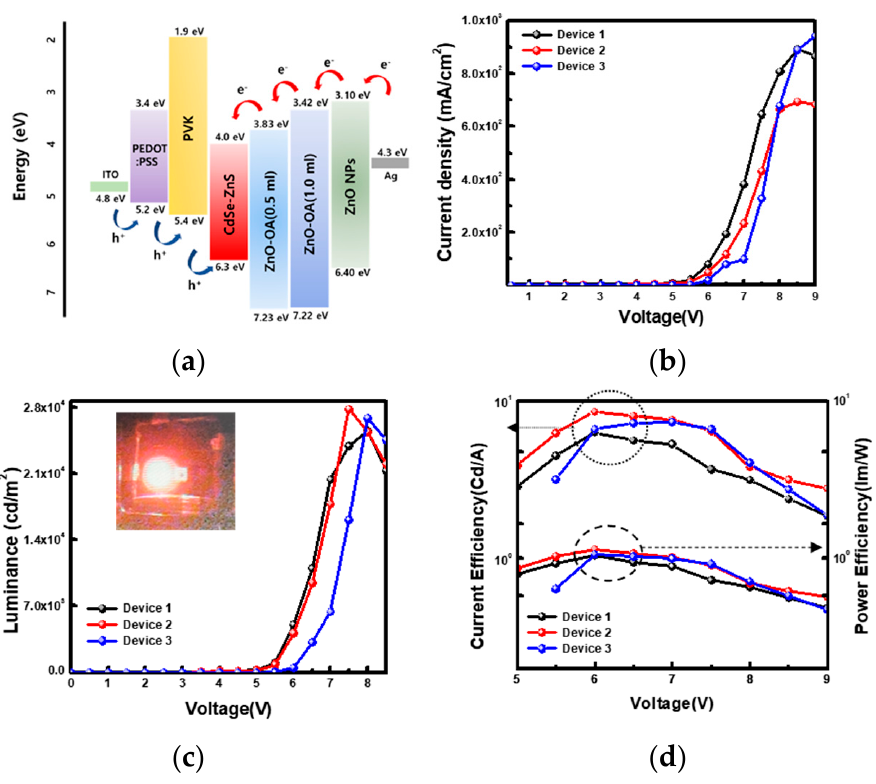
Figure 14. QLEDs structure with ( a ) ZnO-OA(0.5 mL, 1.0 mL)/ZnO-QDs ETLs. ( b ) current density (J)-voltage (V) for device 1 (QLEDs-S1), device 2 (QLEDs-D1), and device 3 (QLEDs-D2). ( c ) Luminance-voltage curves and ( d ) current efficiency (power)-voltage curves for device 1, 2 and 3.